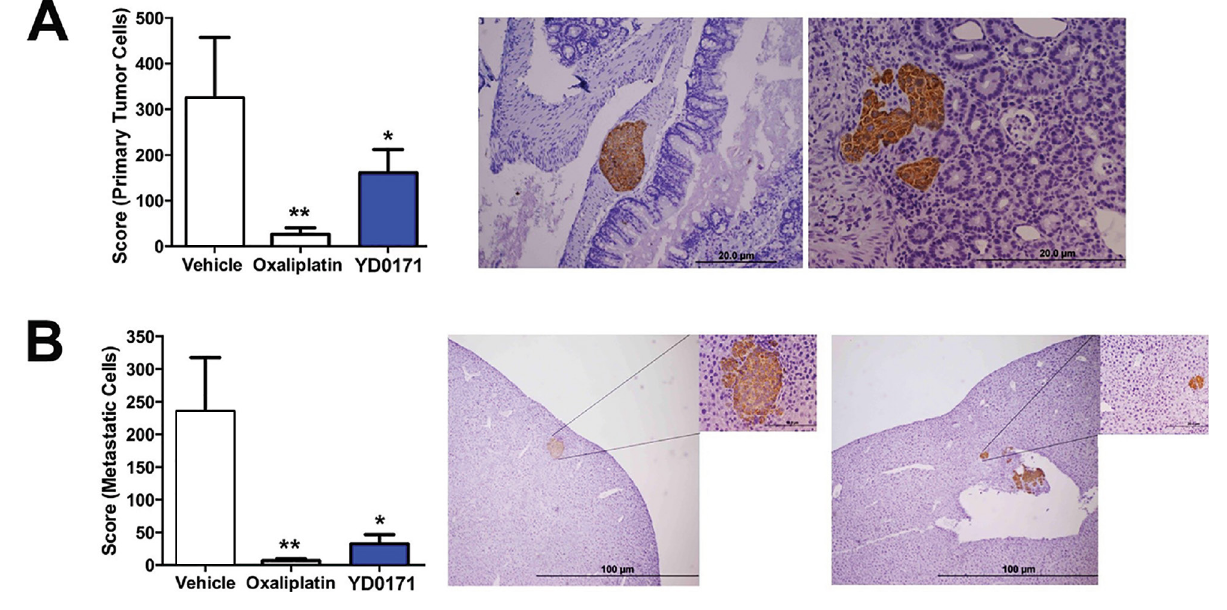
Figure 18. YD0171 inhibits tumor growth and metastasis formation in nude mice subjected to intracecal HCT116 cell implantation. Mice were subjected to intracecal implantation of HCT116 cells. On posttumor injection d 3, mice were randomized into subcutaneous treat- ment with either vehicle, YD0171 (1 mg/kg) or oxaliplatin (5 mg/kg), each 5 d/wk. On posttumor injection d 51, the cecum, liver, lung and lymph nodes were harvested, and primary tumor size (cecum) and metastasis (liver, lung and lymph nodes) were quantified using a weighted score. Right side panels show representative photomicrographs and histological pictures of (A) the primary tumor and (B) the liver metastasis; human tumor tissue is highlighted by the brown staining. Data represent mean ± SEM values of n = 6–8 animals per group; * p < 0.05 and ** p < 0.01 indicate a significant inhibitory effect of YD0171 compared with vehicle